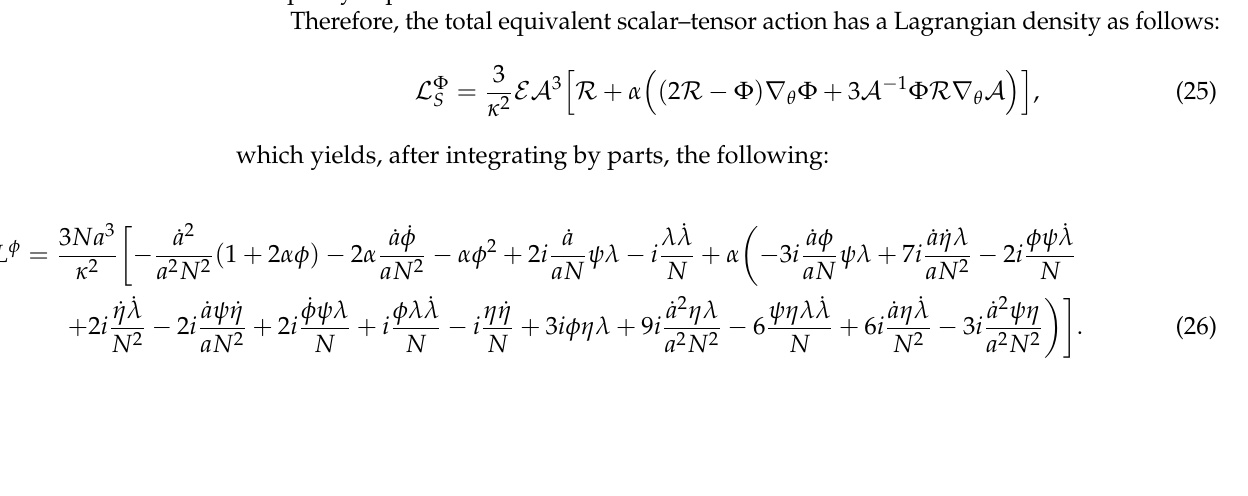
Figure 1. Numerical solution to (23) with initial values a = 1, H = 5 M , ˙ H = − 1 M = 0.2. ( a ) Logarithm of a ( t ) ; ( b ) comoving Hubble length (scale